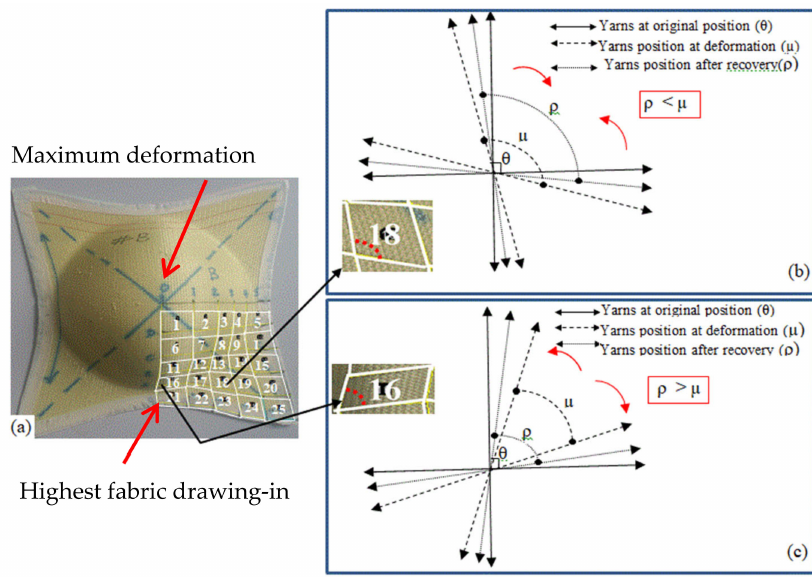
Figure 8. ( a ) The deformed preform and its di ff erent measurement angles on the surfaces of the deformed preform to determine for in-plan shear angle values and its recovery ( b , c